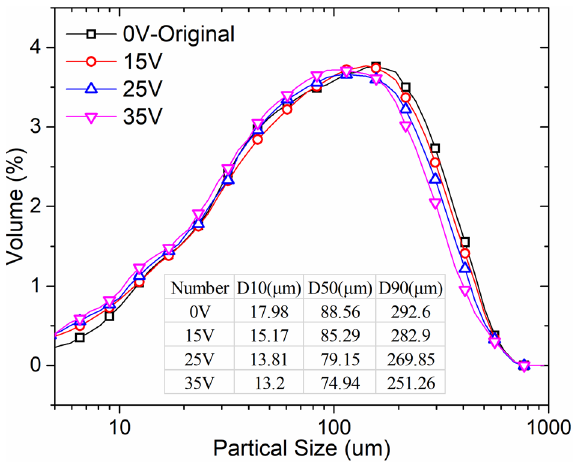
Figure 7. Sludge particle size distribution.